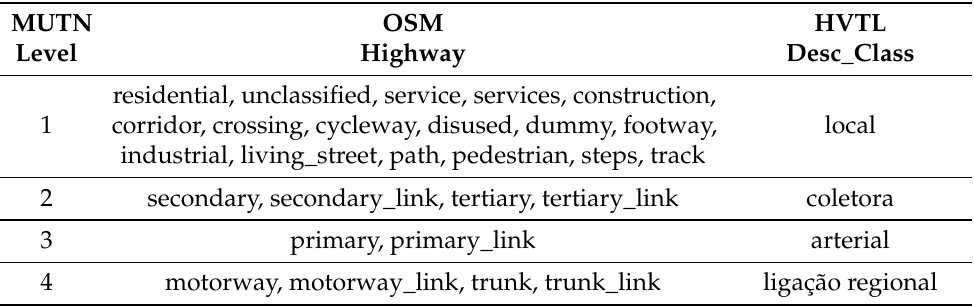
Table 3. Value mapping for attribute ‘ level ’ in the segments of the MUTN data model.